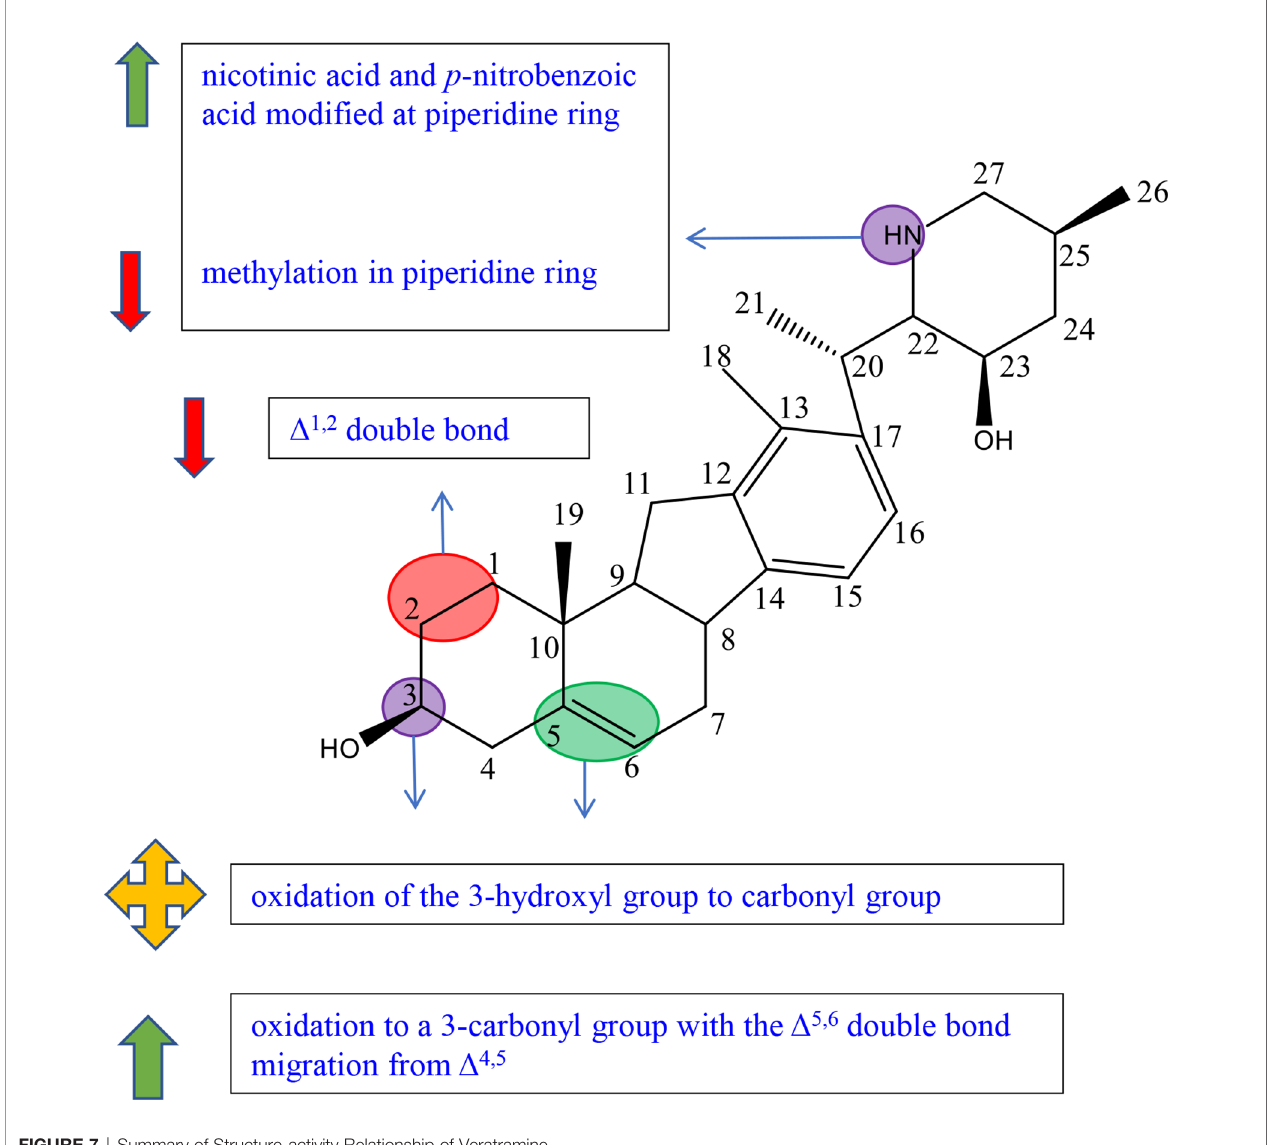
FIGURE 7 | Summary of Structure-activity Relationship